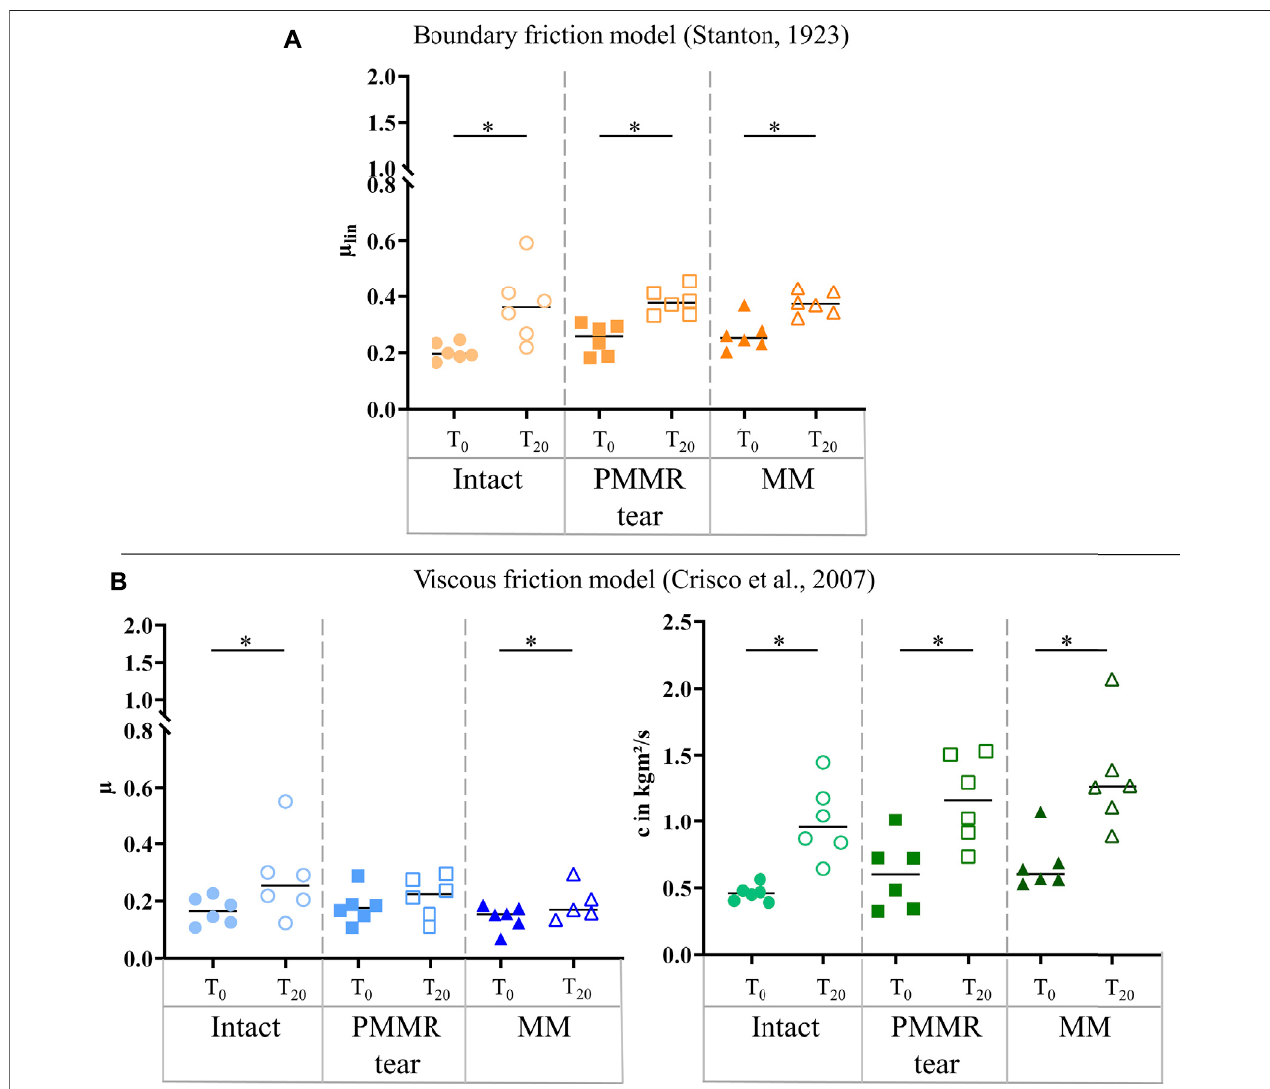
FIGURE 9 | (A) Scatter plots (median with individual values) of the boundary friction coef fi cient (µ lin , symbol color: orange) under stance phase conditions. (B) Scatterplots(medianwithindividualvalues)oftheviscousfrictioncoef fi cient(µ,symbolcolor:blue)andtheviscousdampingcoef fi cient(c,symbolcolor:green)inkgm 2 /s under stance phase conditions. Each joint was tested in three consecutive meniscus states: intact (symbol shape: circles), with a posterior medial meniscus root tear (PMMR tear) (symbol shape: squares) and medial meniscectomy (MM) (symbol shape: rectangles). The tests were performed directly after loading the joints with 1000 N (T 0 , fi lled symbols) and after resting under the axial load for 20 min (T 20 , un fi lled symbols). Non-parametric statistical analyses: n (cid:1) 6; * p < 0.05.